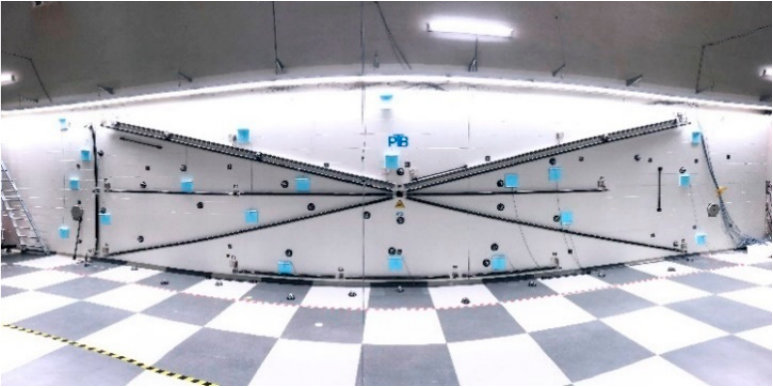
Figure 2. A photograph of PTB’s reference wall with the installed targets and markers for the photogrammetry system being tested. The maximum length is approximately 12 m (diagonals). The reference wall allows the lengths between the nests to be calibrated with a com- parably low calibration uncertainty. For this purpose, the individual lengths wee com- bined to form five groups: one vertical line (Line A), two diagonal lines (Lines B and C), and two horizontal lines (Lines D and E) at different heights of the wall. The lines connect either three or four nests (two or three calibrated lengths). Diagonal Lines B and C are approximately 12 m long, while Lines A, D, and E are about 3 m, 10 m, and 6 m long,